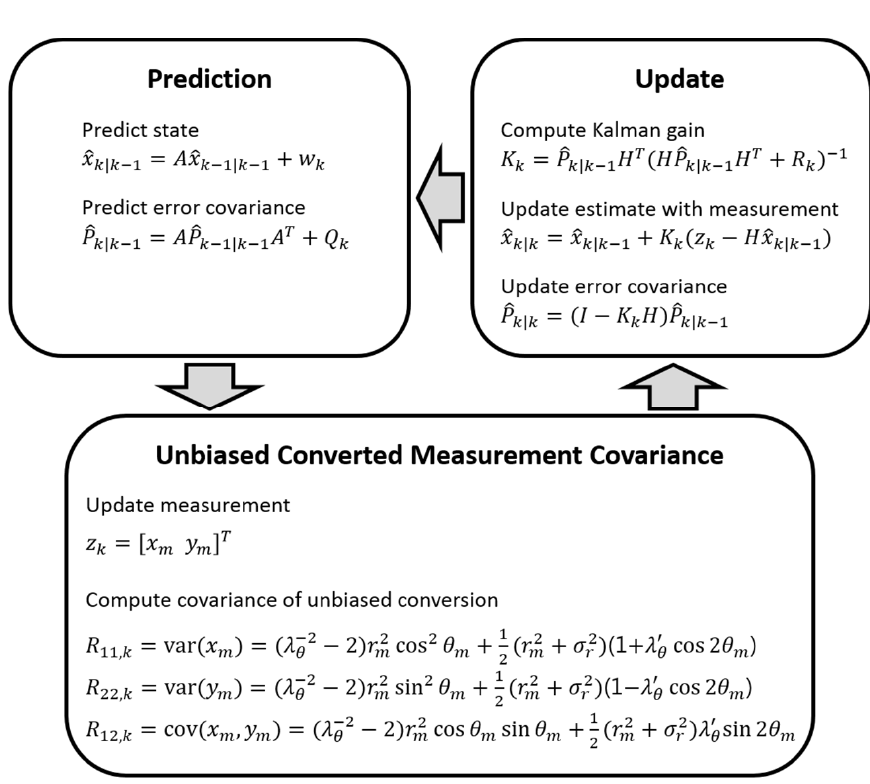
Figure 3. Operation of the unbiased converted measurement Kalman filter algorithm.